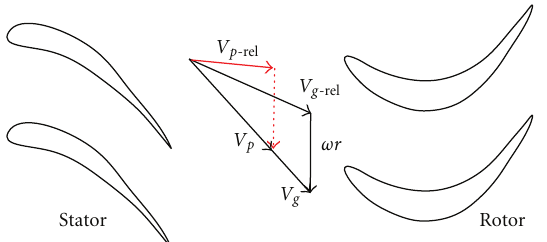
Figure 17: Schematic showing e ff ect of particle slip velocity at the stator exit on entrance condition in the rotor reference